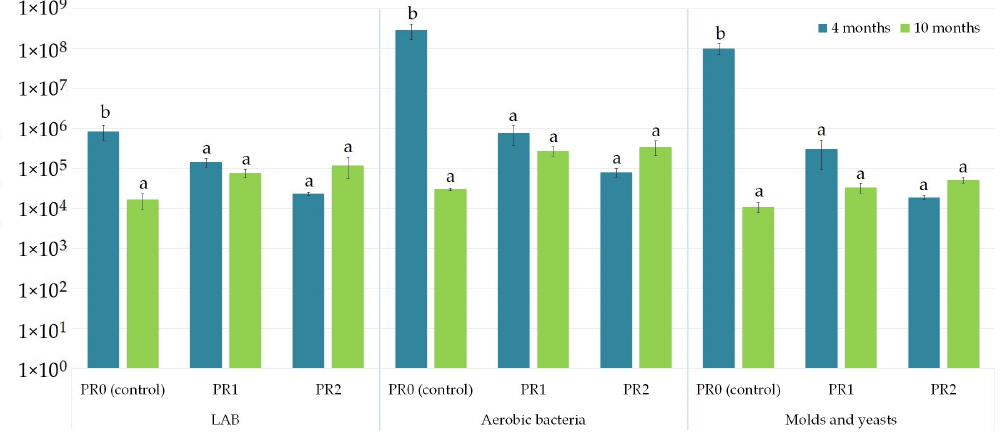
Figure 7. Microbial population changes during the second stage of the experiment. Storage time: 4 and 10 months. Bars marked with the same letters indicate no statistical difference ( p < 0.05); results were analyzed separately for each group of microorganisms.